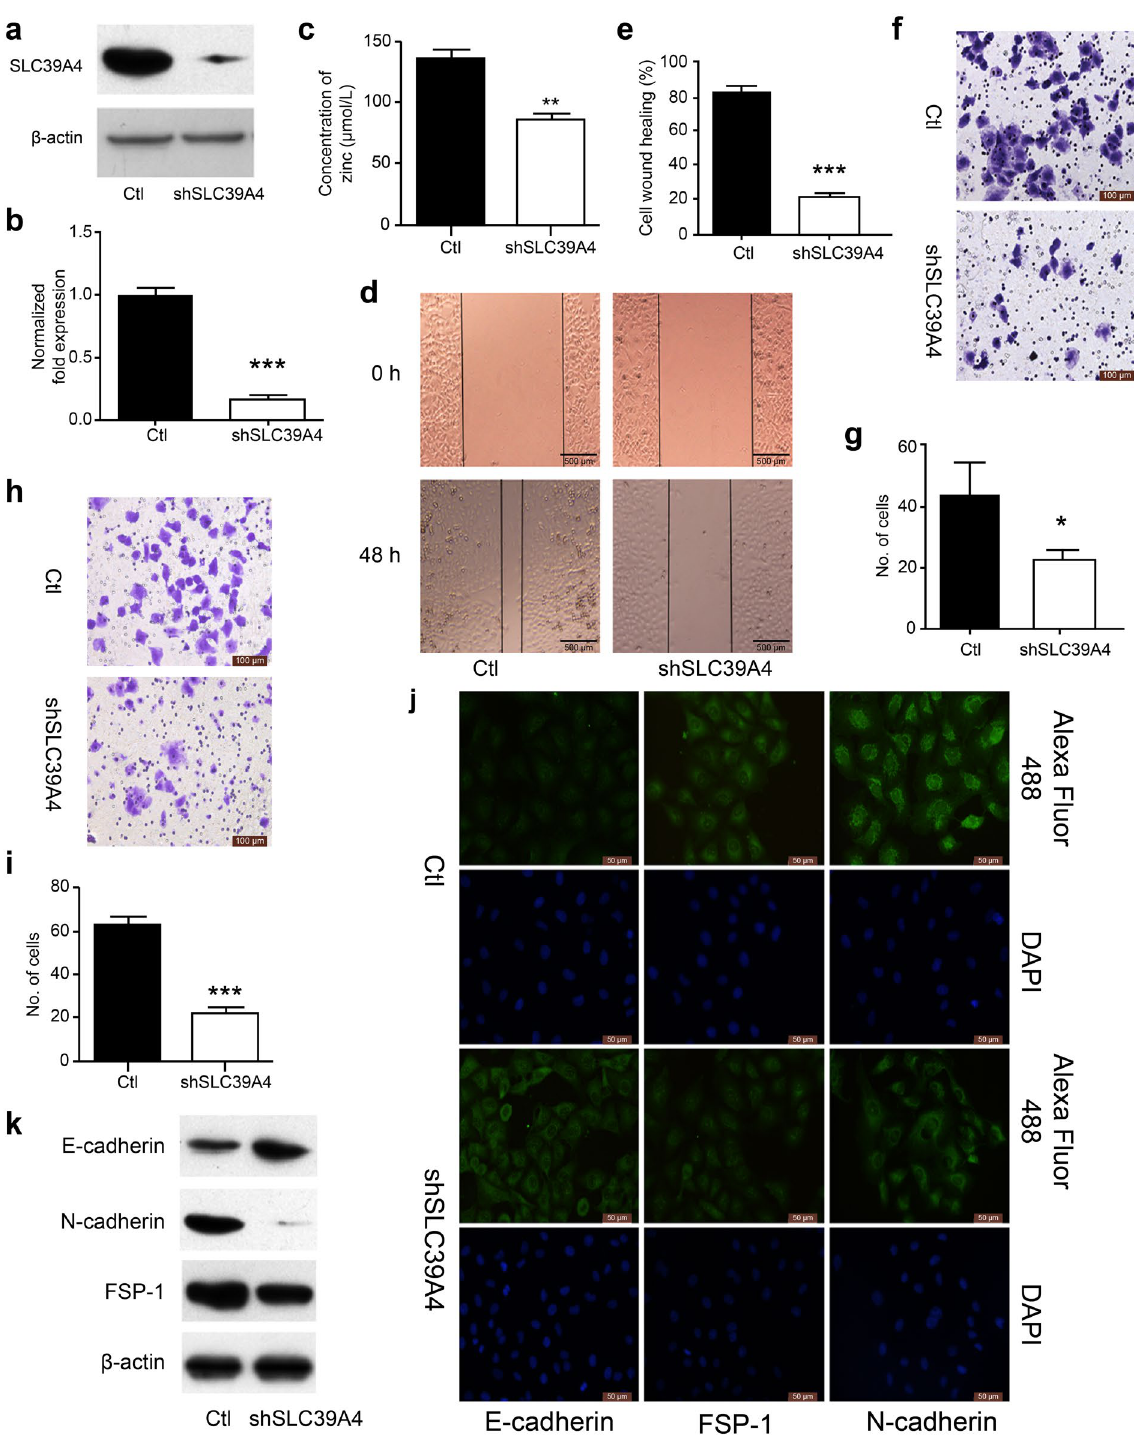
Figure 3. SLC39A4 silencing inhibits A549 cells metastasis in vitro . ( a , b ) SLC39A4 expression in A549 knockdown and empty vector control (Ctl) cells by western blot analysis ( a ) and qPCR ( b , c ). Zn 2 + concentration in A549 cells after knockdown of SLC39A4 in vivo . ( d , e ) Analysis of SLC39A4 knockdown and Ctl cell migration in wound-healing assays (scale bar, 500 μ m). Representative images ( d ) and quantitation ( e ) are shown. ( f , g ) Cell migration was monitored in transwell assays with SLC39A4 knockdown and Ctl A549 cells (scale bar, 100 μ m). Representative images ( f ) and quantitation (g) are shown. ( h , i ) Cell invasion was monitored in matrigel transwell assays with SLC39A4 knockdown and Ctl A549 cells (scale bar, 100 μ m). Representative images ( h ) and quantitation ( i ) are shown. ( j , k ) Analysis of E-cadherin (epithelial marker) and FSP-1 and N-cadherin (mesenchymal markers) expression in knockdown and control cells by immunofluorescence staining ( j ) and western blotting ( k ) (scale bar, 50 μ